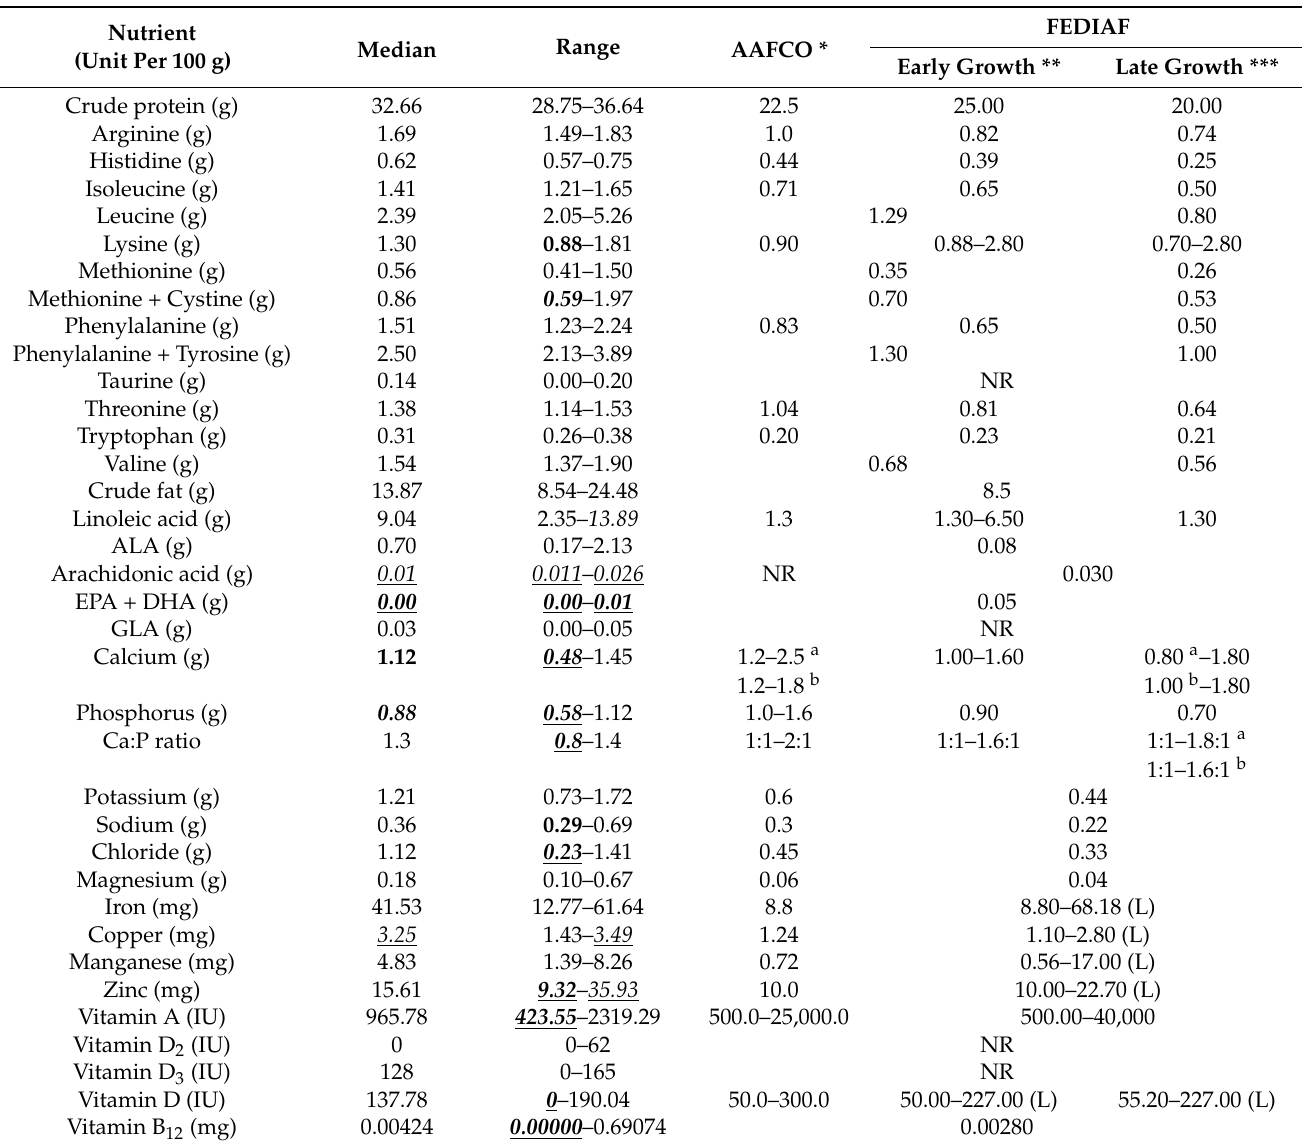
Table 2. Measured nutrient content in seven plant-based canine foods commercially available in Canada and labeled for puppies or all life stage compared to the AAFCO and FEDIAF recommended essential nutrient concentrations for canine growth on dry matter basis (unit per 100 g dry